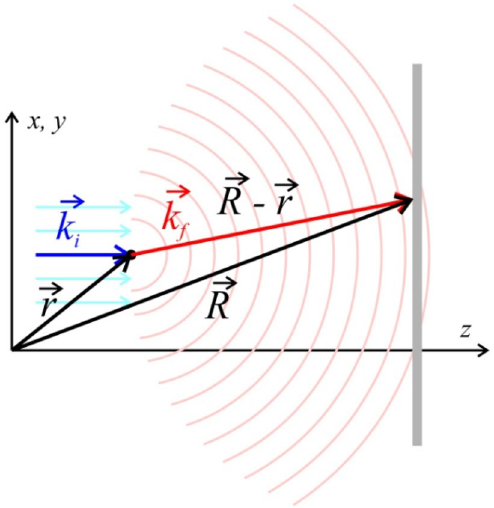
Figure 6. Coordinates and symbols used in calculation of X-ray